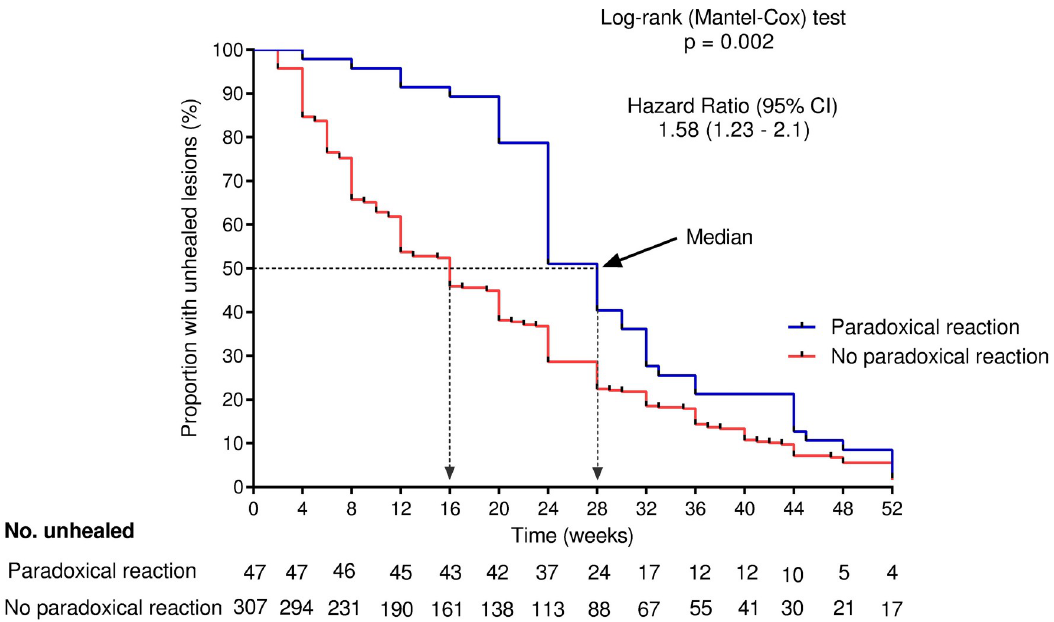
Fig 5. Kaplan Meier analysis for time to complete healing in Buruli ulcer patients who developed paradoxical reaction and those who did not following antibiotic treatment. Broken lines indicate the median healing time (weeks) for each group.